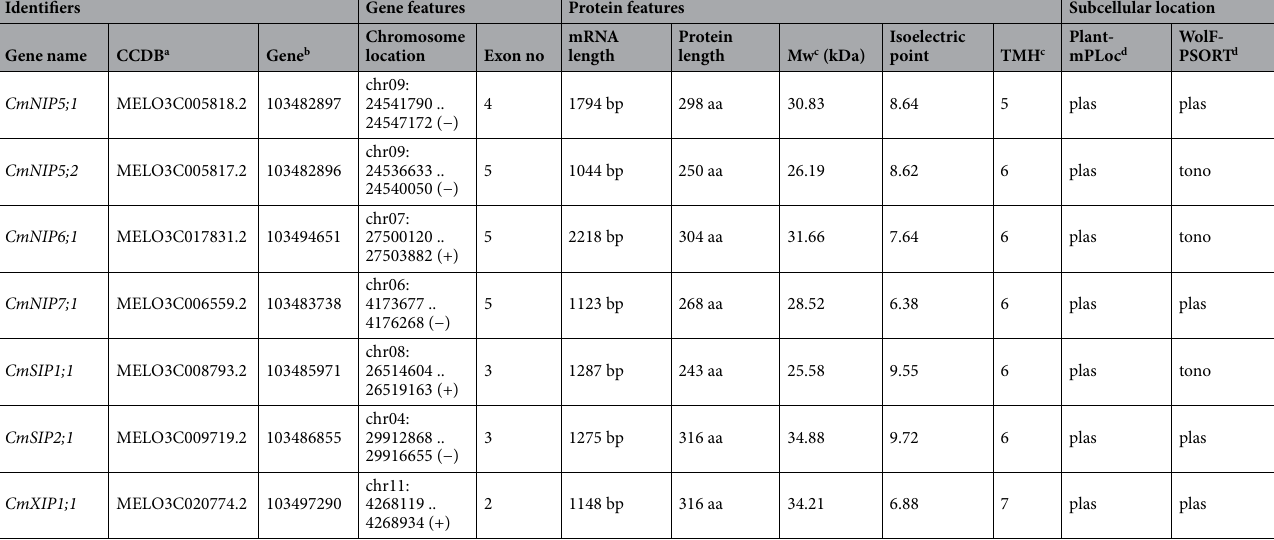
Table 2. List of the 31 aquaporins found in C. melo (Cm). Columns: Identifiers (Gene name, ID from Cucurbit genomics database and NCBI accession), Gene features (chromosome location and exons number), protein features (mRNA length, protein length, molecular weight, isoelectric point and predicted number of transmembrane domains) and subcellular location prediction by Plant-mPLoc and Wolf-PSORT